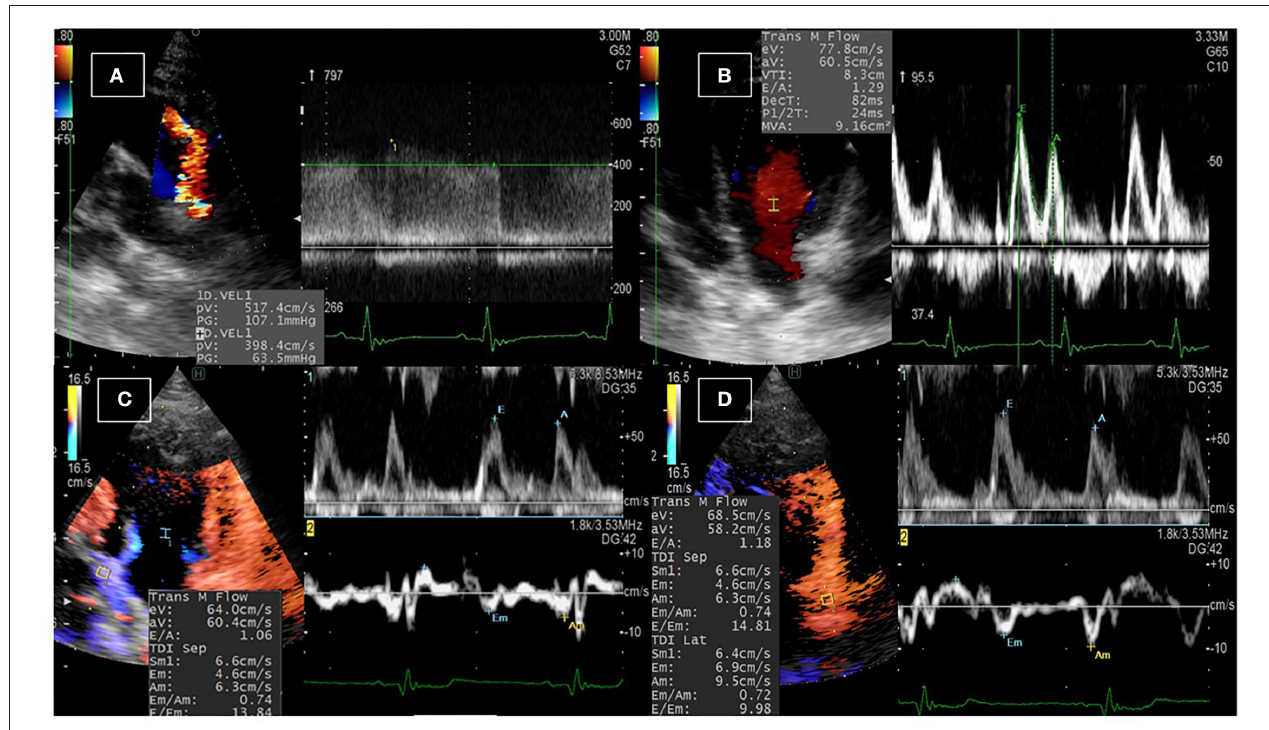
FIGURE 1 | Conventional echocardiographic examination in dogs with PDA. (A) The PDA shunt was detected upon echocardiographic examination from the left parasternal short-axis view at the base of the heart using color Doppler echocardiography, and the velocity of the blood flow across the shunt was detected using continuous-wave Doppler echocardiography. (B) Pulsed-wave Doppler echocardiography of the transmitral flow was used to measure the early and late diastolic peaks. (C,D) Dual Doppler imaging of the transmitral flow and the tissue Doppler imaging at the septal (C) and the free (D) wall of the left ventricle to measure the early inflow velocity to early tissue velocity (E/Em)